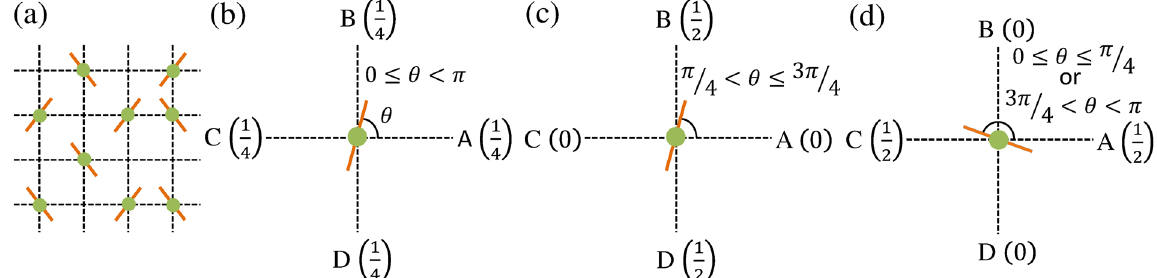
Figure 3. Model figure. ( a ) Two dimensional square lattice with occupied ( n = 1) or unoccupied ( n = 0) sites. Filled circles indicate the occupied sites. Inclinations of the rods towards the horizontal direction show respective particle orientations θ ∈ [0, π ]. ( b ) Equilibrium move: particle can move to any of the four neighbouring sites with equal probability 1/4. ( c , d ) Active move: particle can move to either of its two neighbouring sites with probability 1/2, if unoccupied, in the direction it is more inclined to, i.e., along BD in ( c ), and AC in ( d